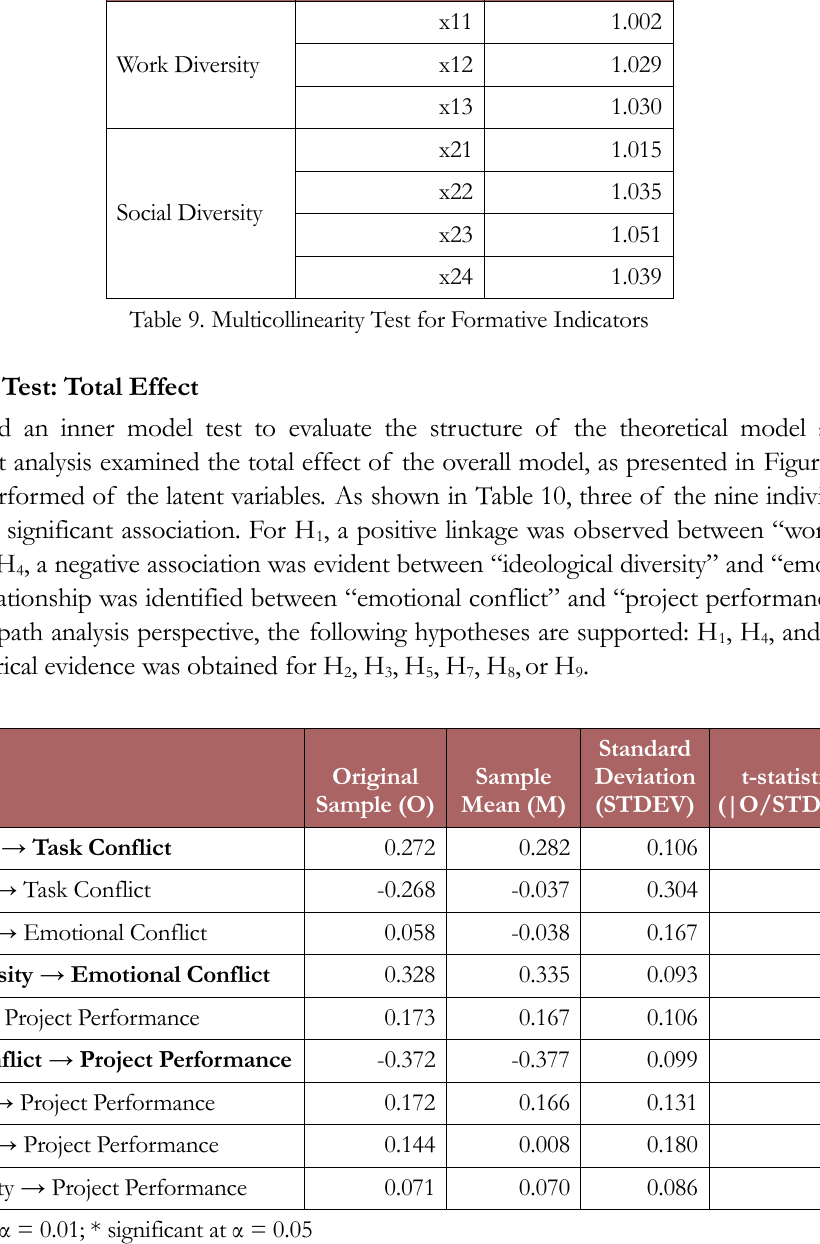
Table 10. Inner Model Path Analysis (Total